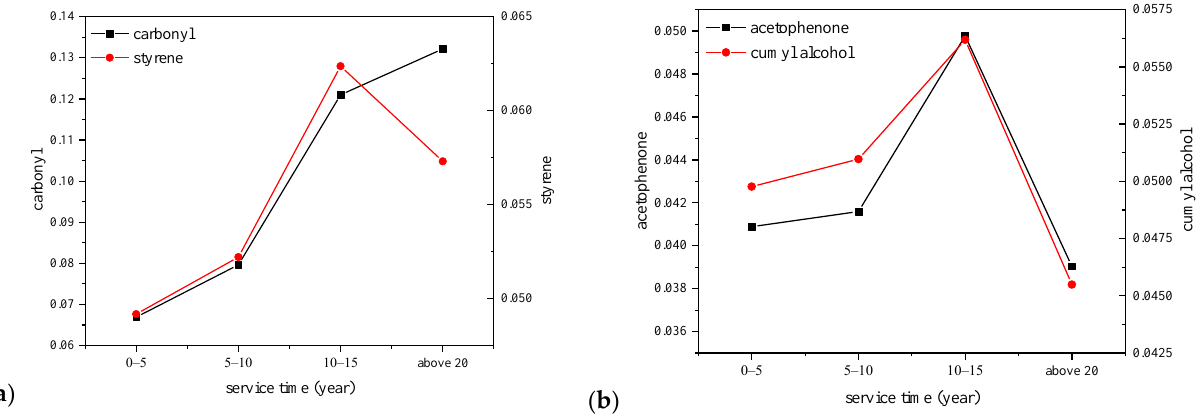
Figure 7. Typical functional group characteristics with the relationship of cable service year. ( a ) Carbonyl and styrene; ( b ) Acetophenone and cumyl alcohol.